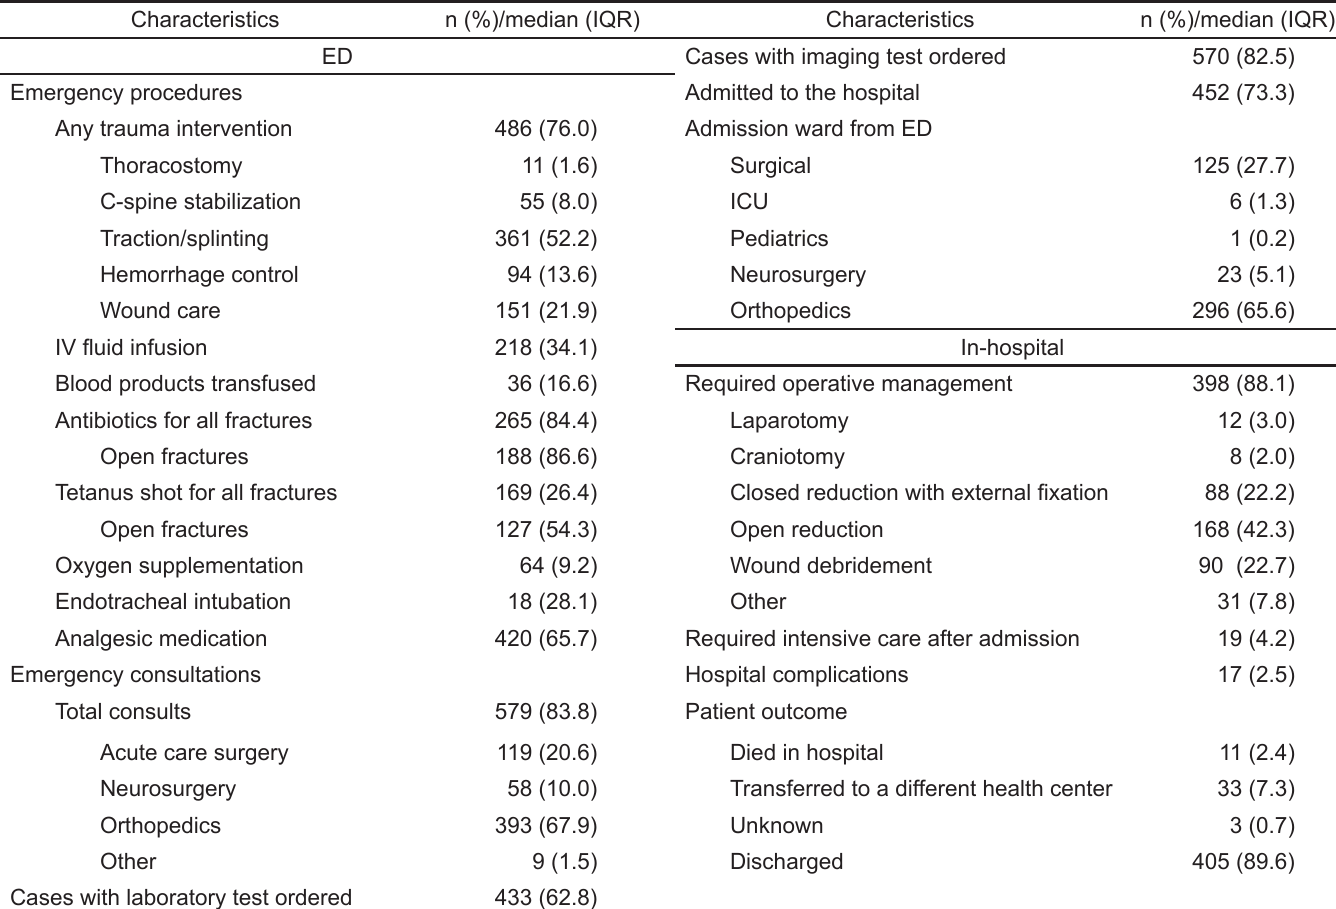
Table 2. Care delivery for musculoskeletal injuries.